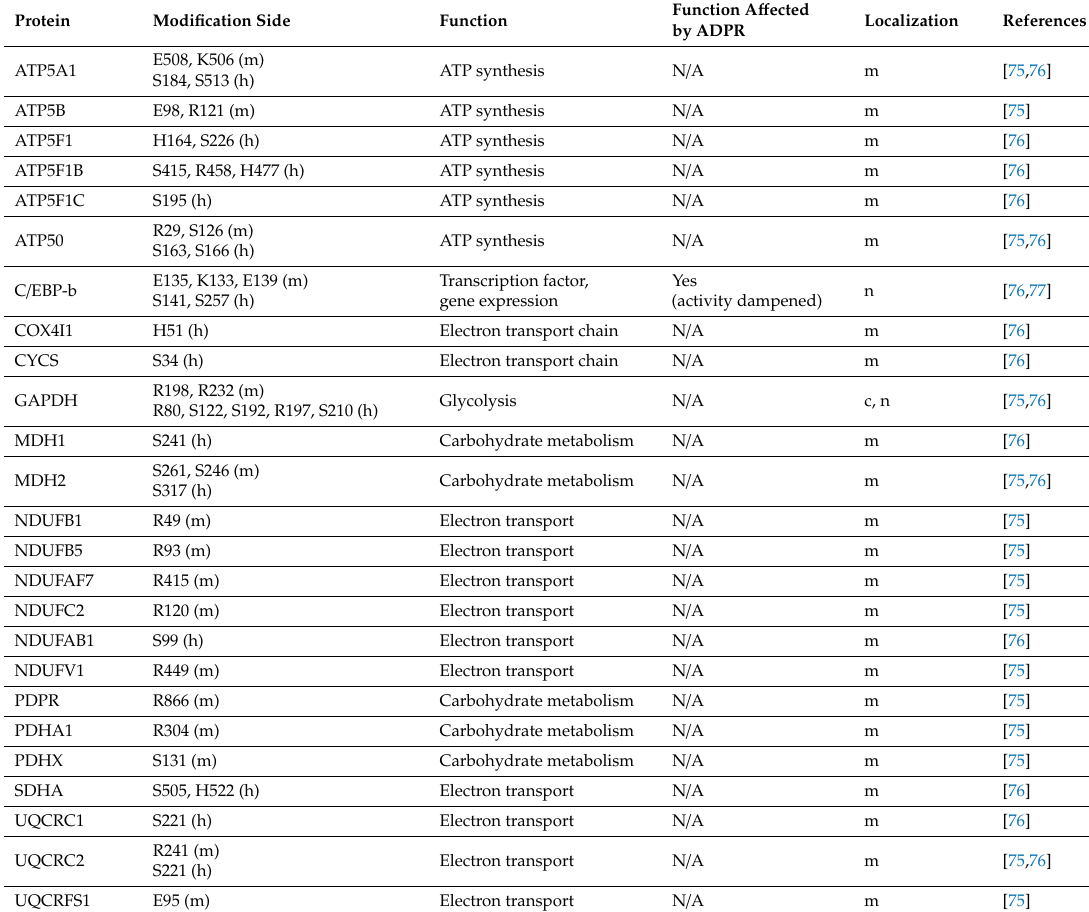
Table 1. Overview of ADP-ribosylated proteins involved in glucose metabolism with assigned ADP-ribose amino acid acceptor site and their